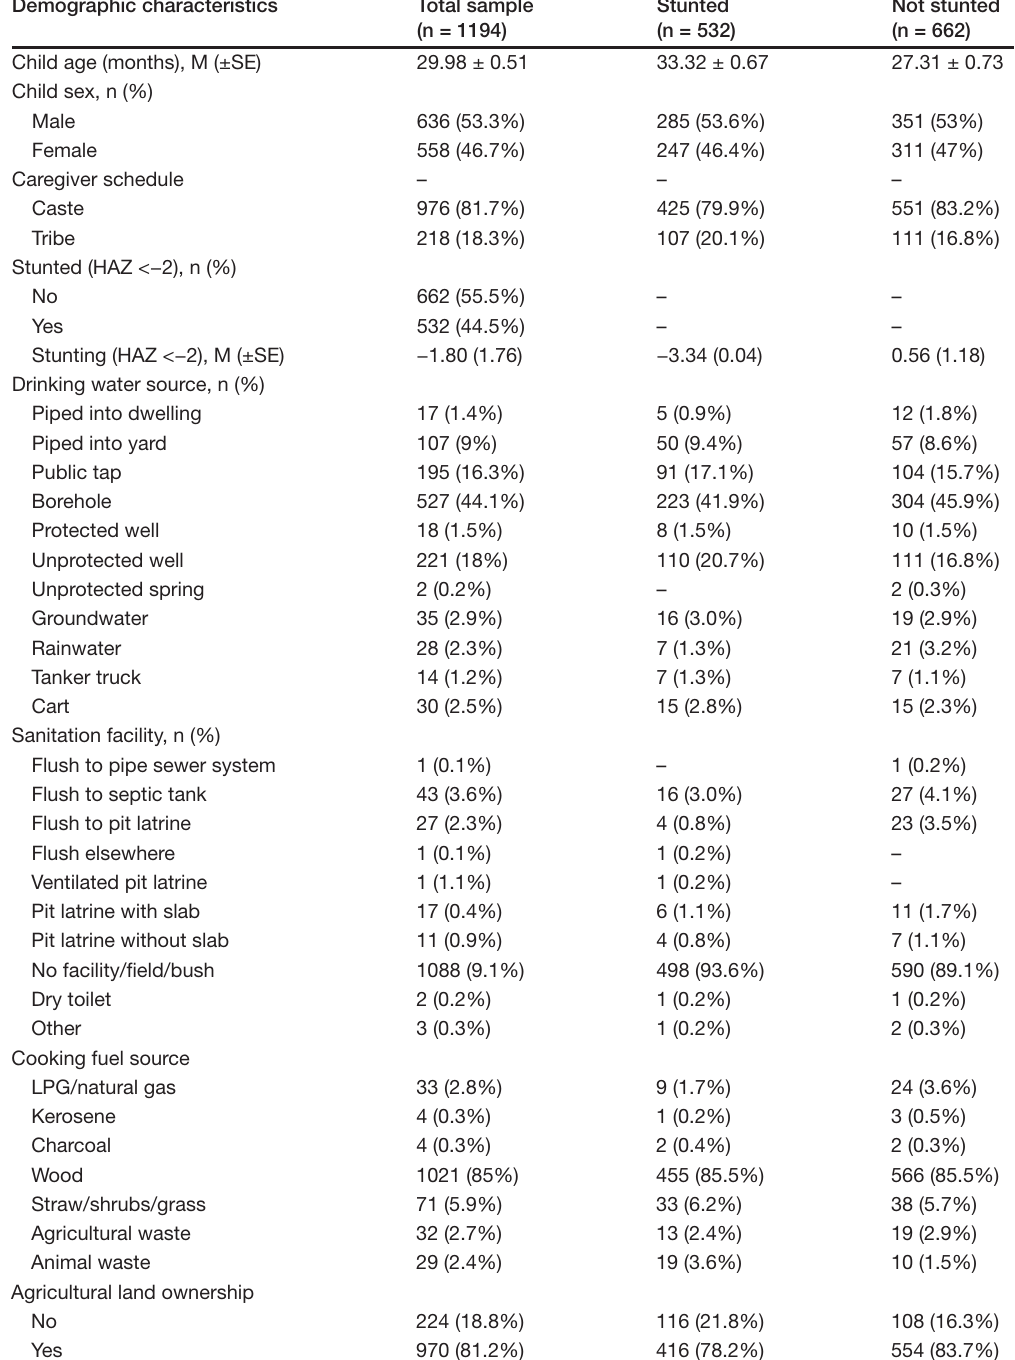
Table 1. Characteristics of cases under 5 years of age included in the sample. Demographic